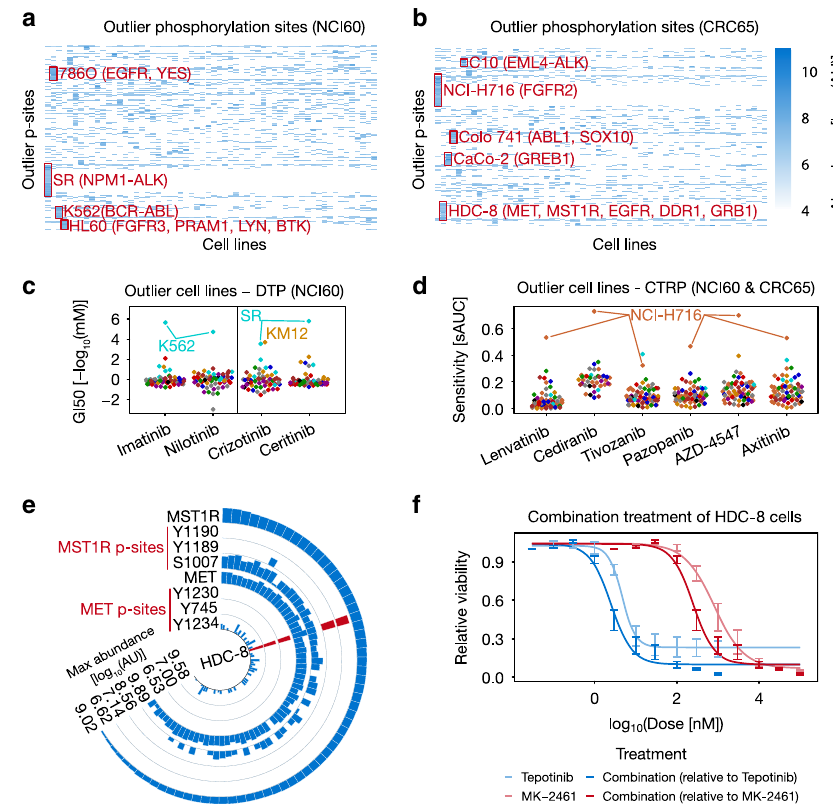
Fig. 3 Outlier proteins and p-sites abundance often explain drug sensitivity. a , b Heatmaps of outlier p-sites in the a NCI60 ( n = 60 cell lines) and b CRC65 panel ( n = 64 cell lines). Selected cell lines and p-site clusters are annotated. c , d Beeswarm plots visualizing selected drugs for which outlier cell lines were identi fi ed in the c DTP ( n = 59 cell lines) and d CTRP drug-sensitivity datasets (Lenvatinib: n = 71 cell lines; Cediranib: n = 41 cell lines; Tivozanib: n = 72 cell lines; Pazopanib: n = 71 cell lines; AZD4547: n = 66 cell lines; Axitinib: n = 69 cell lines; sAUC = 1-standardized area under the dose- response curve; GI50 = growth inhibitory concentration analogous to an IC50). Cell lines are colored by tissue of origin as in Fig. 1. e Circular bar plot highlighting the outlier abundance of selected pY-sites on MET and MST1R in HDC-8 cells (red bars; n = 65 cell lines). f Dose-response curves visualizing the synergistic effect of targeting MET (using Tepotinib) and MST1R (using MK-2461) simultaneously in HDC-8 cells. Error bars represent the minimum and maximum relative viability of technical triplicates. Source data are provided as a Source Data fi